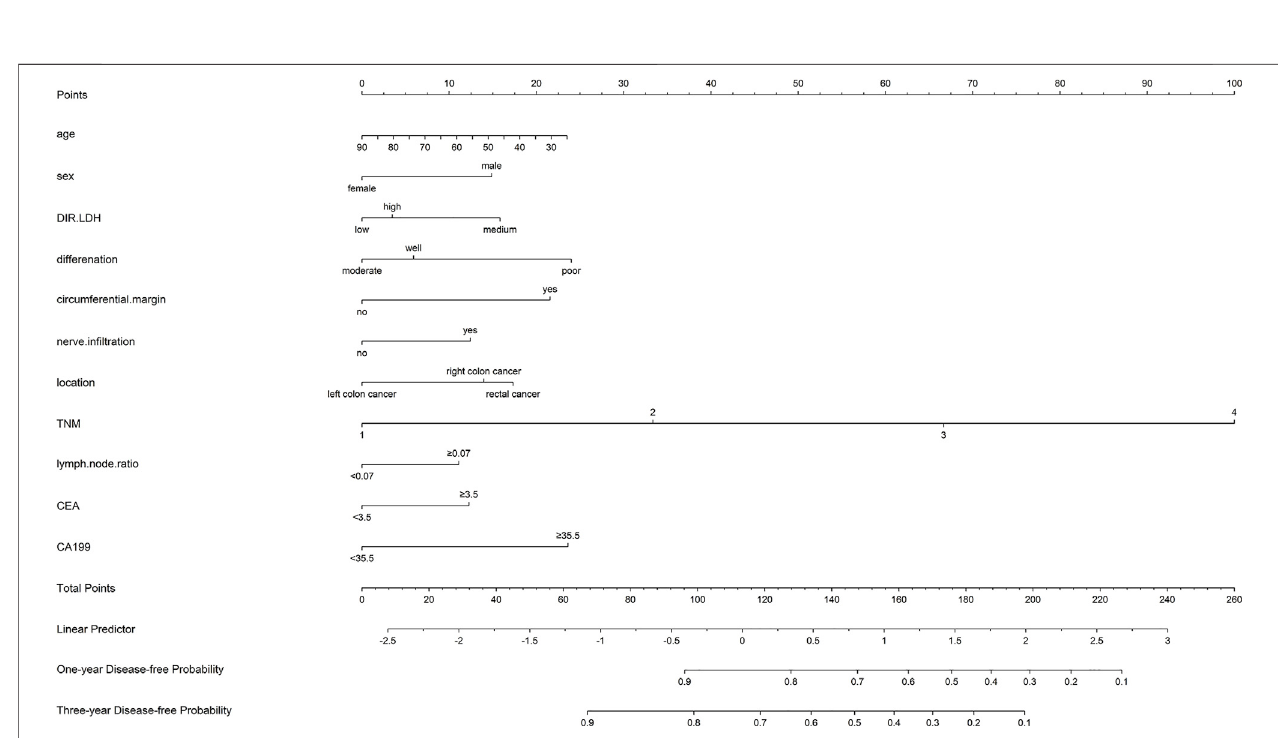
FIGURE 5 | Nomogram of the prognostic model for the DFS of patients with colorectal cancer.